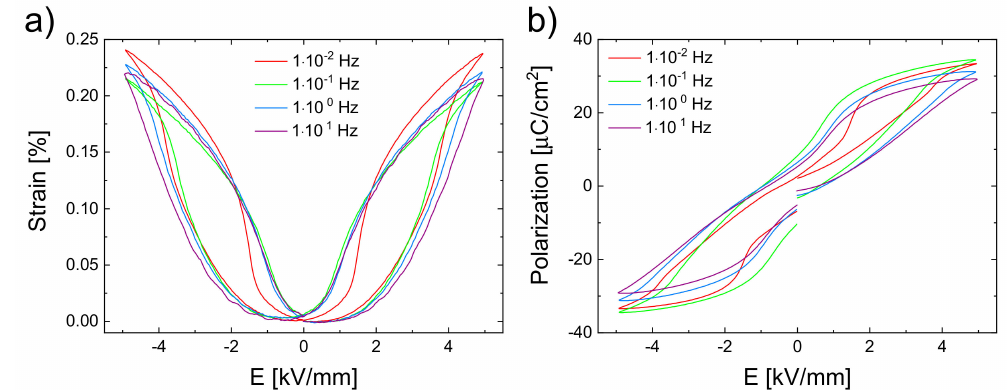
Figure 2. Macroscopic ( a ) strain and ( b ) polarization curves of the BNT–12BT sample at di ff erent frequencies resulting from one bipolar cycle of an applied electric field of 5 kV / mm.